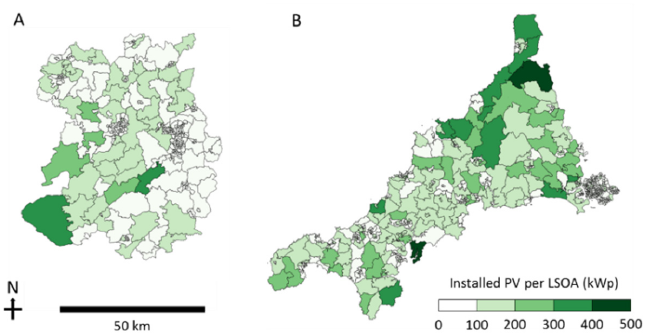
Figure 7. Domestic PV deployment in rural case study regions of ( A ) Shropshire and ( B ) Cornwall.